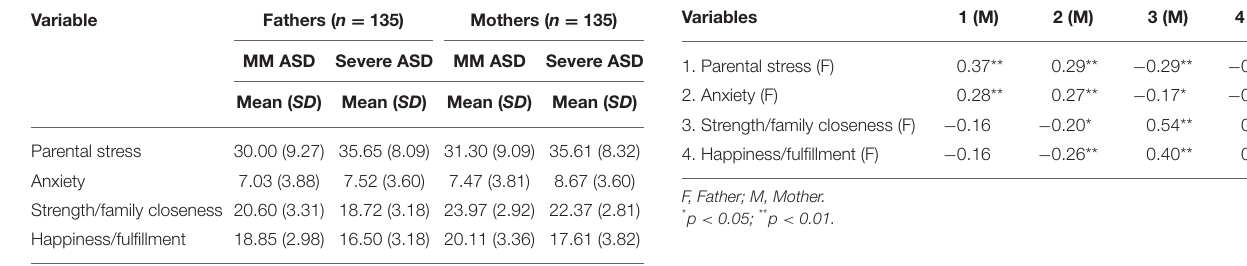
TABLE 3 | Descriptive statistics of the studied variables in mothers and fathers of the two ASD severity groups. Variable